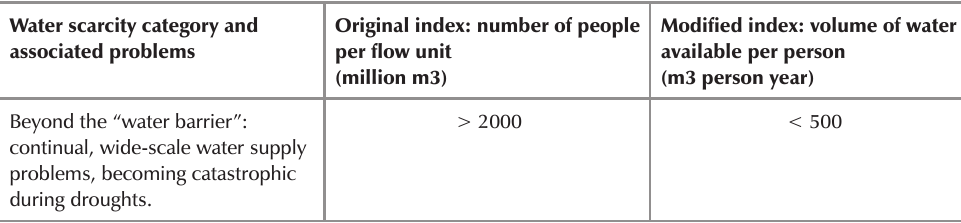
Categories of water scarcity associated with varying levels of water supply per person per year, the typical scales of problems encountered in each category in Africa Water scarcity category and associated